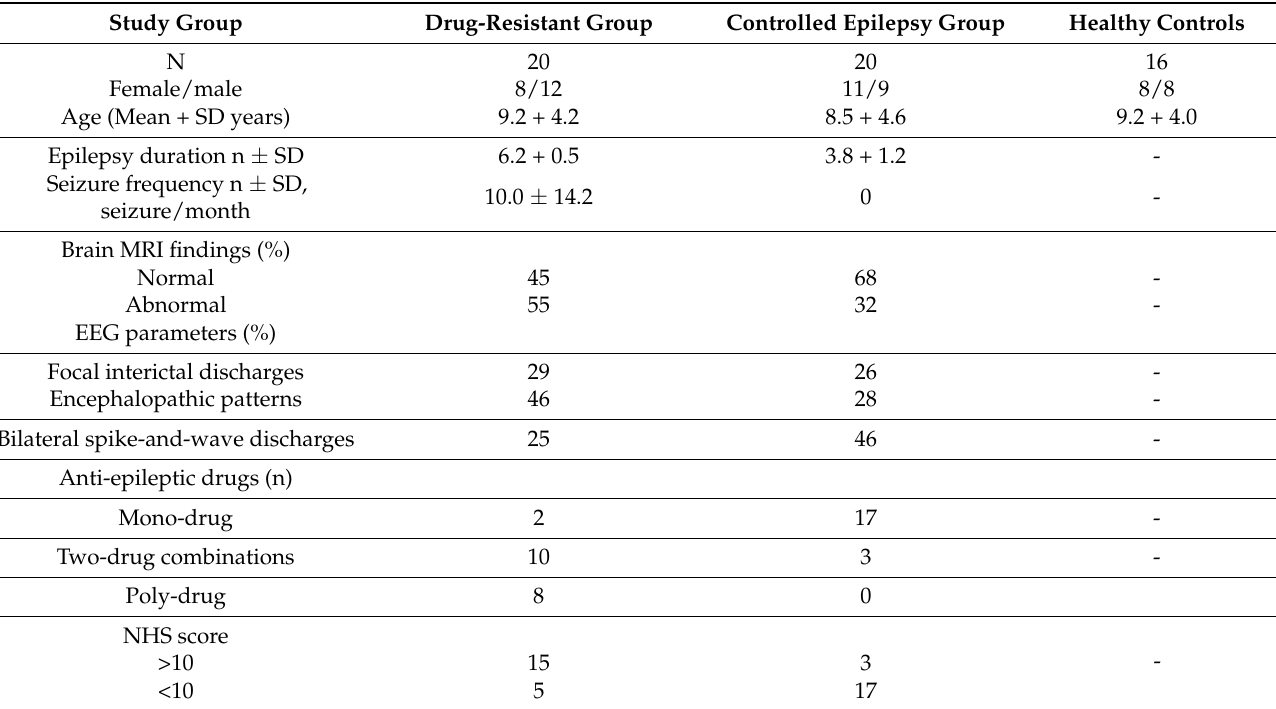
Table 1. Descriptive statistics for the clinical, radiological and electrophysiological characteristics of the study participants. Presented as quantitative data within groups, as percentages and means ±